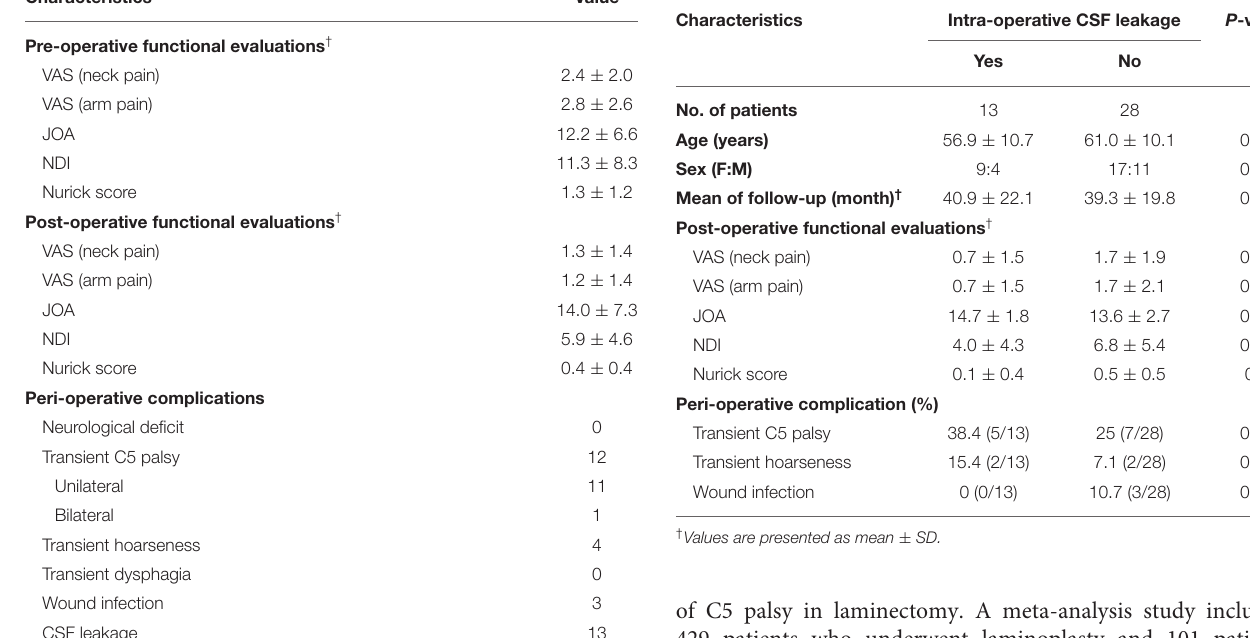
TABLE 3 | Comparison of characteristics between the patients with and without intra-operative CSF leakage.